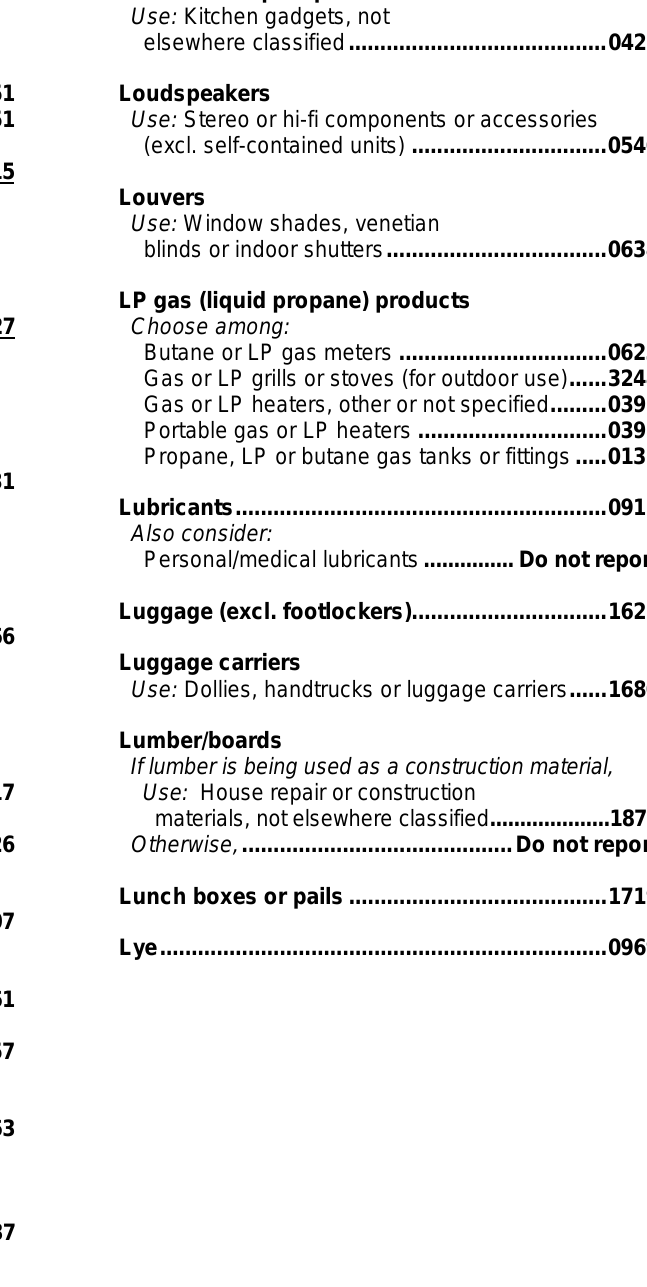
Loom, for beading, jewelry, or weaving Use : Art and ceramic supplies